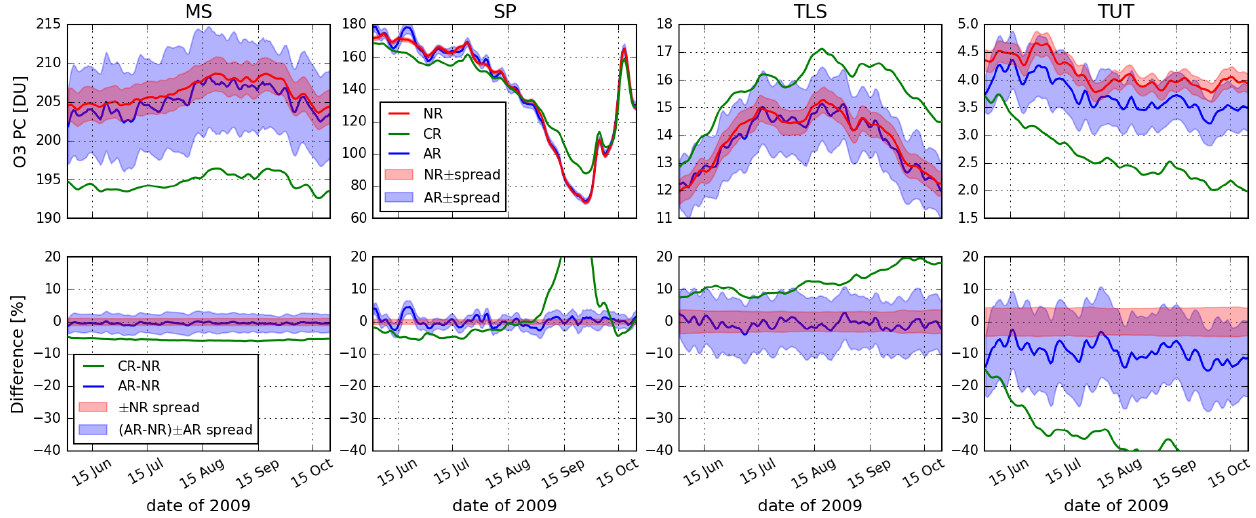
Figure 12. Top: time series of ozone partial column (PC, in Dobson units – DU) of NR (red lines), CR (green lines) and AR (blue lines) in four regions of the stratosphere: the middle stratosphere (MS, defined within 4–50hPa and 50 ◦ S–50 ◦ N), the lower stratospheric South Pole region (SP, within 10–100hPa and poleward 70 ◦ S), the tropical lower stratosphere (TLS, within 70–100hPa and 25 ◦ S–25 ◦ N) and the tropical upper troposphere (TUT, within 100–200hPa and 25 ◦ S–25 ◦ N). The envelopes around the lines of the nature and assimilation runs correspond to the standard deviations of their respective ensemble state. Bottom: time series of the differences between {CR, AR} and NR normalized by NR (%). The red and blue envelopes correspond to, respectively, the NR spread (%, normalized by NR) and AR spread around the (AR − NR)